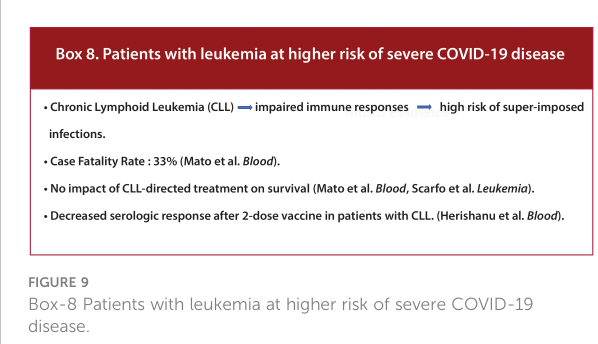
FIGURE 9 Box-8 Patients with leukemia at higher risk of severe COVID-19